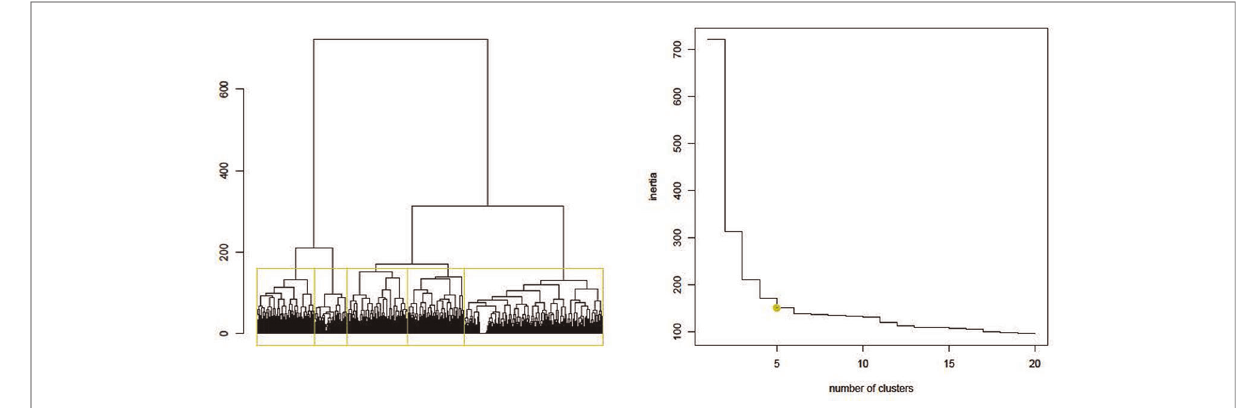
FIGURE 2 Dendrogram and inertia jump curve for the choice of the number of groups.